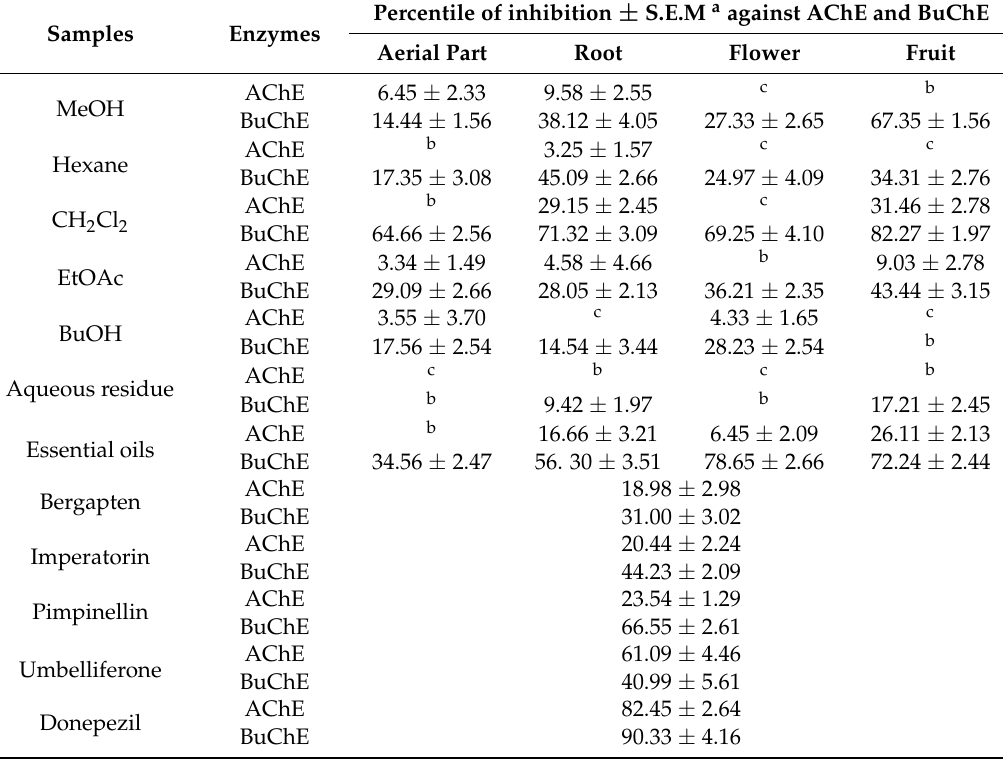
Table 2. In vitro AChE and BuChE inhibitory activities of samples from Zosima absinthifolia at 20 µ g/mL. Samples Enzymes